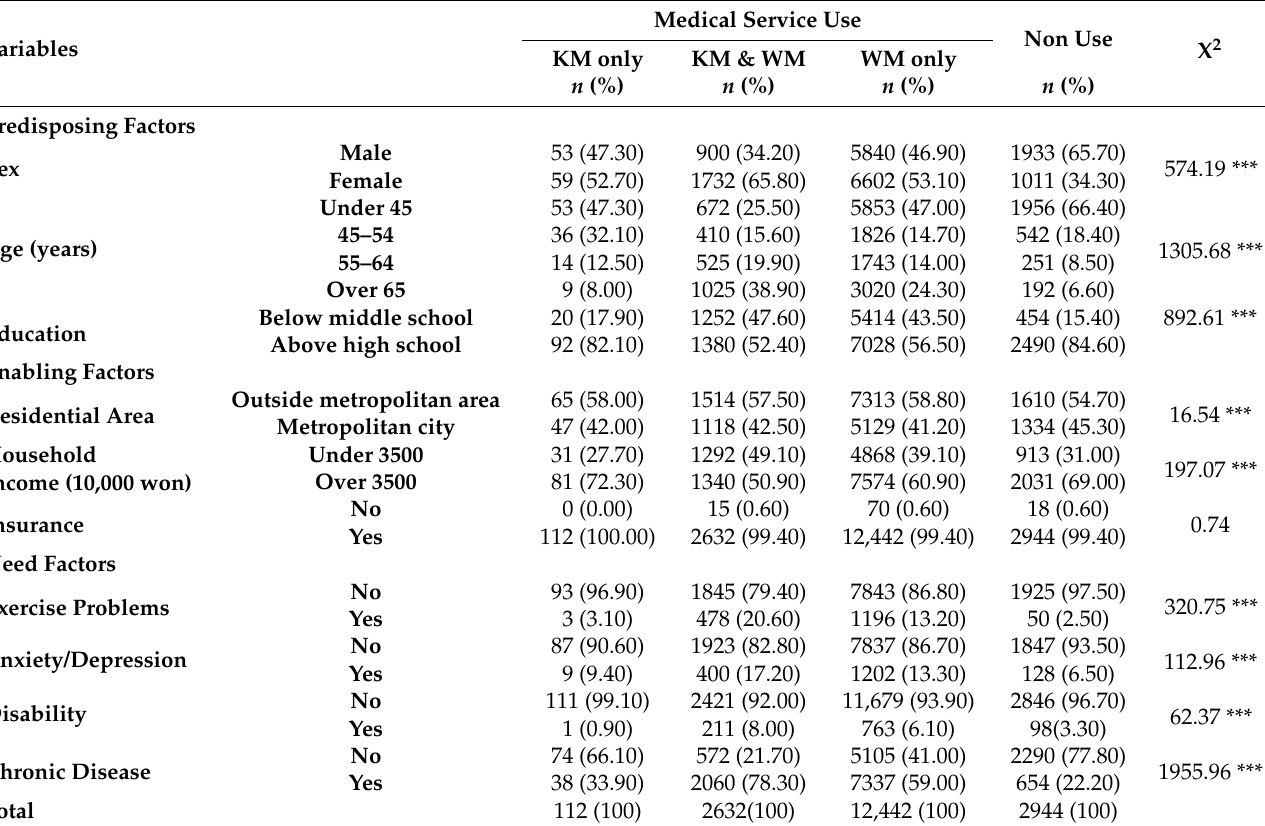
Figure 1. Classification of KM use and WM use by outpatient medical users. Table 4. Chi-square Analysis of KM and WM Service Use ( n = 18,130, All